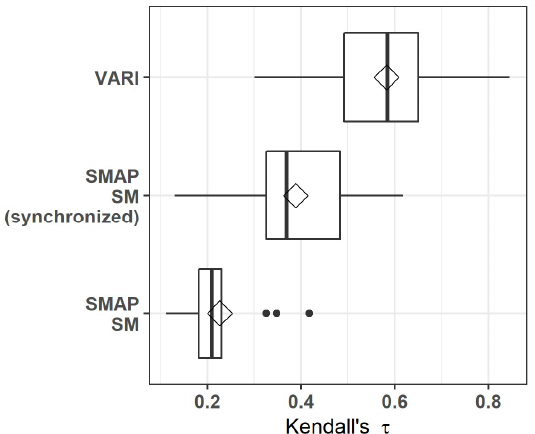
Figure 5. Kendall’s tau between LFM and MODIS VARI, SMAP SM, and SMAP SM synchronized to the LFM time series. The average tau across the 12 sites are marked as a diamond in the boxplot.